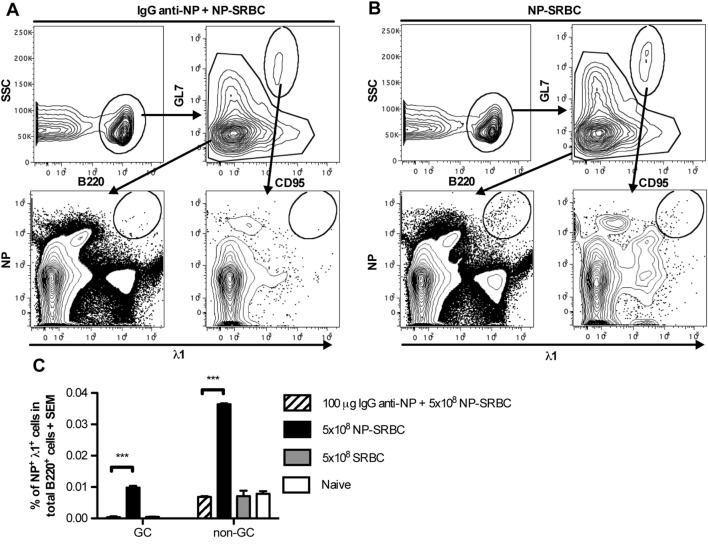
IgG suppresses NP-specific extrafollicular antibody secreting cells and NP-specific germinal centers (GCs) B cells. C57BL/6 mice were immunized with 5 × 108 NP-sheep red blood cell (SRBC) ± 100 μg polyclonal IgGa anti-NP, 5 × 108 unconjugated SRBC, or left untreated. After 6 days, spleens were harvested and half of the spleen samples were analyzed with flow cytometry (A–C) and the other half with confocal microscopy (D–I). (A,B) Gating strategy for GC and non-GC NP+λ1+ cells. (C) Frequency of GC and non-GC NP+λ1+ cells among total B220+ cells. (D–G) Representative tile scan sections, stained for IgD+ (blue), and NP+ (red) cells. (H) Enlarged image from (E) (square with dashed lines). (I) Quantification of fluorescence intensity per square micrometer. One representative tile scan image was taken from each mouse and the intensity of red fluorescence (NP+) from each image was summed and then divided by the size of the image. Representative of three independent experiments with 2–4 mice/group. ns, p > 0.05; *p < 0.05; **p < 0.01; ***p < 0.001.